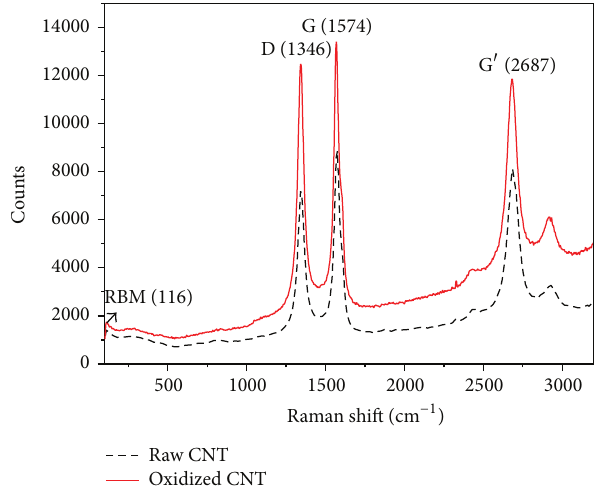
Figure 7: Raman spectrum for the polymer (CA-PA).